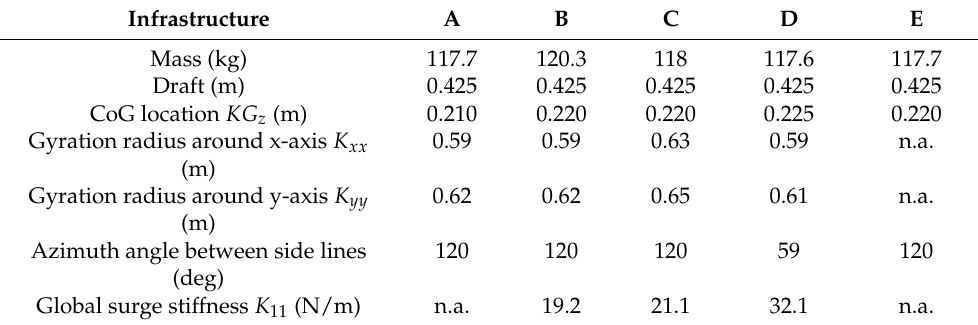
Table 4. Characteristics of the moored model measured at each facility (at basin scale). “n.a.” stands for “not available” when data were not measured or not